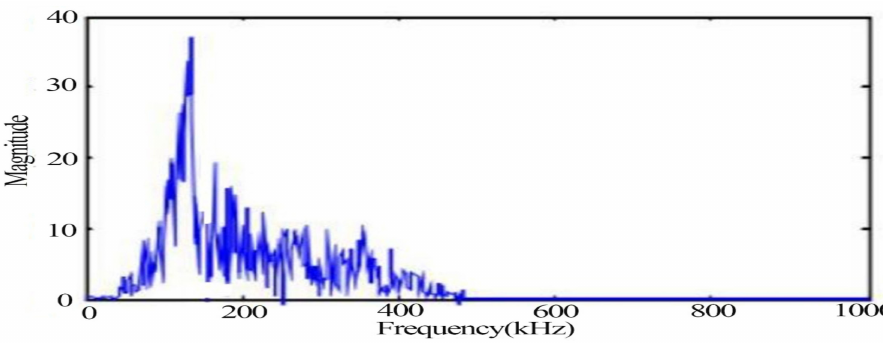
Figure 10. Signal spectrum at the moment of fracture.